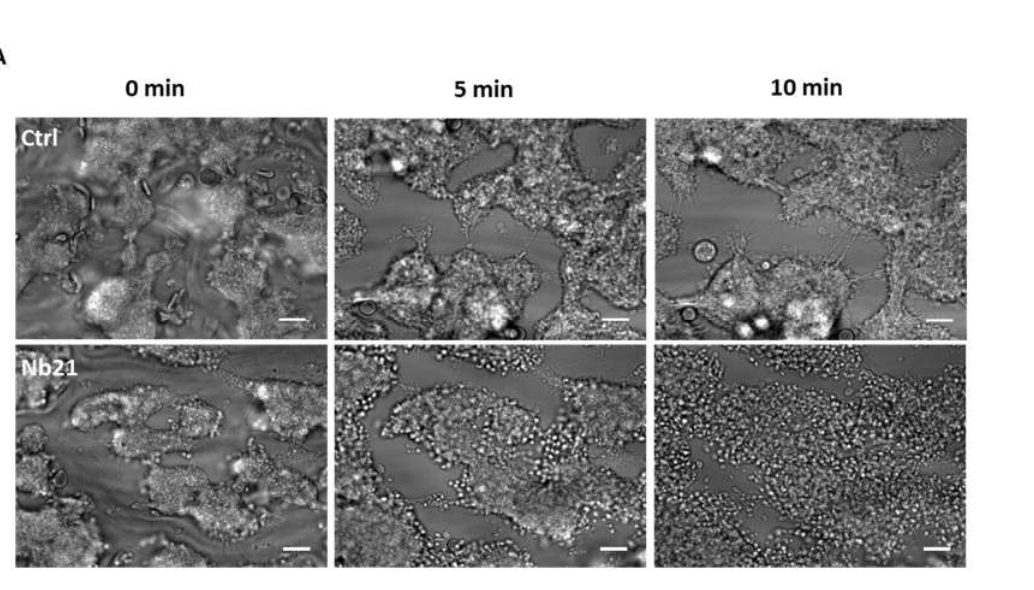
Figure 5. Blockage of GPVI with the anti-GPVI nanobody 21 (Nb21) causes minor thrombus instability. Recalcified blood was perfused for 7 min on Horm collagen at 37 °C at arterial shear (1000 s −1 ), and successively post-perfused for 10 min with rinse buffer and blocking anti-GPVI nanobody Nb21 (500 nM). ( A ) Representative images after perfusion of blood from 6 donors, taken during post-perfusion at time 0, 5 and 10 min. ( B ) Graphs showing extent of disaggregation, moni- tored from recorded brightfield images every min, and measured as morphological, contraction and multilayer scores [16]. Scale bar = 50 µm. Data are shown as mean+s.e.m. * p < 0.05, ** p < 0.005 one-tailed Student’s paired t -test.